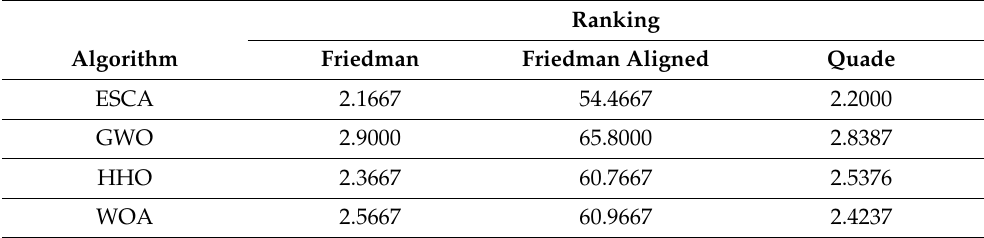
Table 19. Comparison of convergence speed for the assessed algorithms. The average ranking outcomes through Friedman, Friedman aligned, and Quade tests.